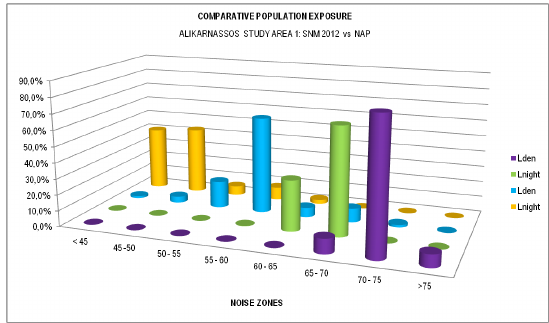
Fig. 18. Alikarnassos study area: Comparison SNM 2012 - NAP Popu- lation exposure to noise indices L den & L night